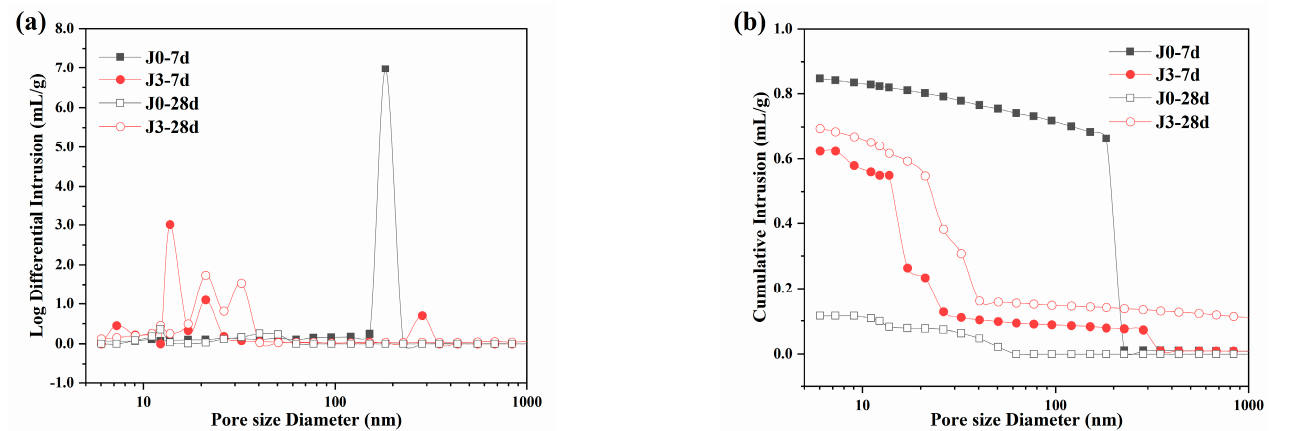
Figure 14. ( a ) Pore size distribution and ( b ) cumulative pore volume of M-S-H cement with SRA under sealed conditions.